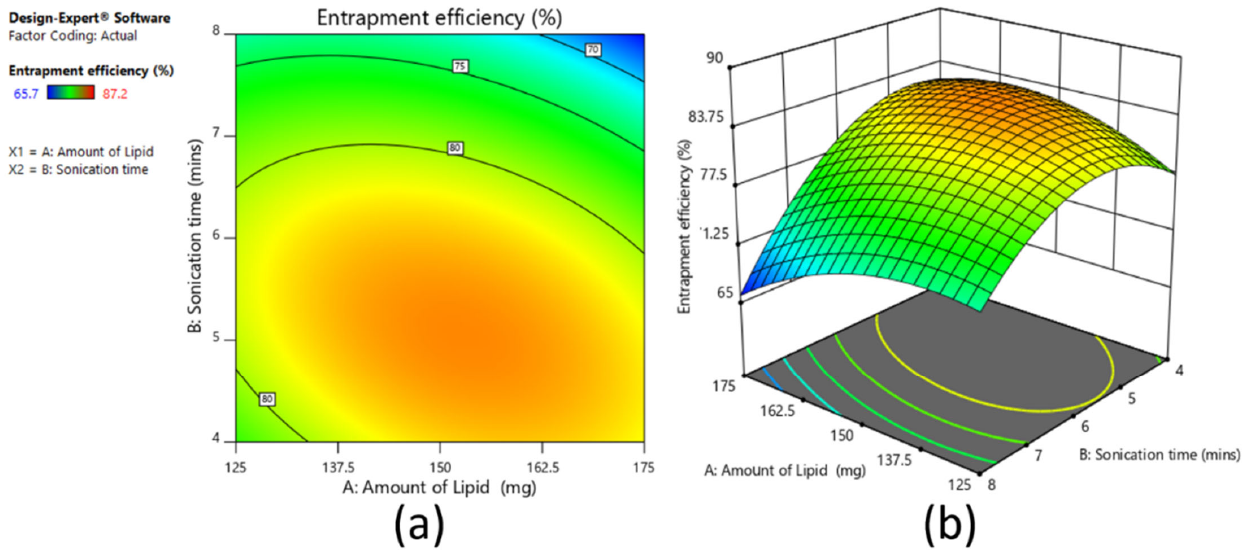
Figure 6. Contour plot ( a ) and 3D surface plot ( b ) representing the effect on percent entrapment efficiency for full factorial design batches.